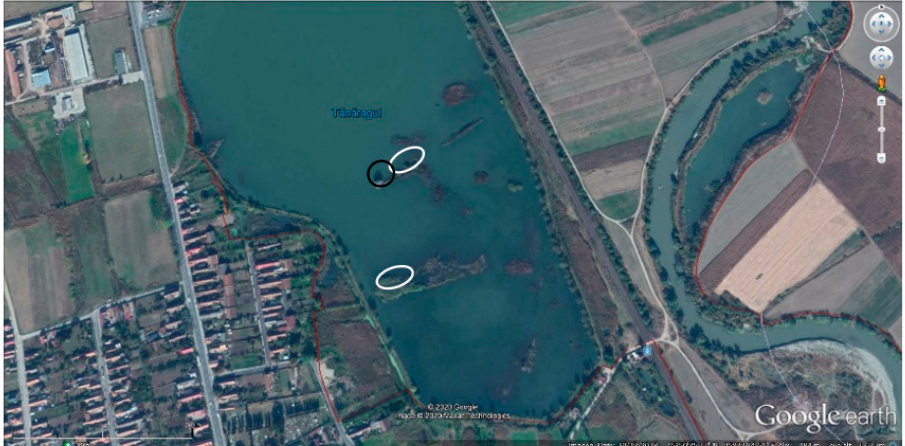
Figure 3. Colony location on Lake 3 Rotbav, 2010–2020 (black circle, Phalacrocorax carbo ; white oval, mixed consisting of Nycticorax nycticorax , Egretta garzetta , Ardeola ralloides ).